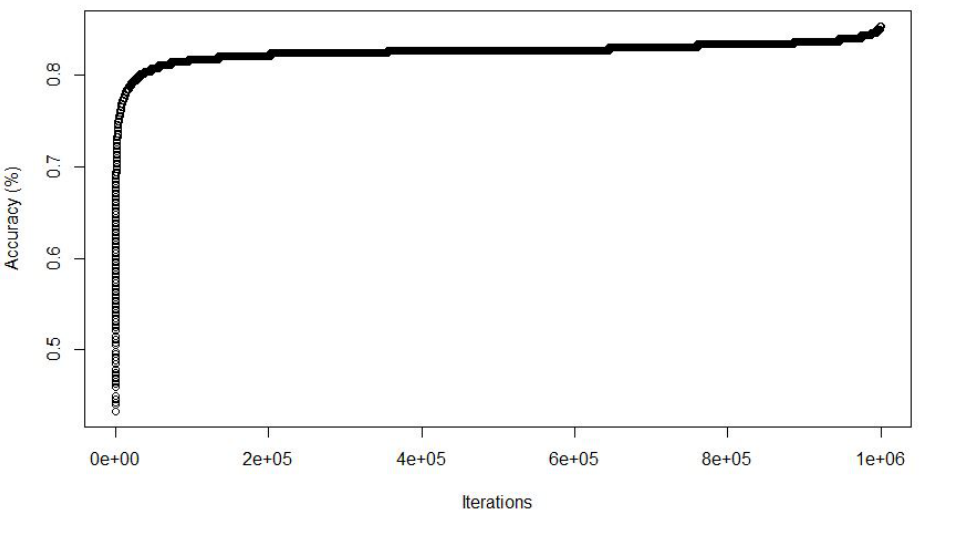
Figure 9. Improvement in accuracy as the number of iterations increases in the optimization